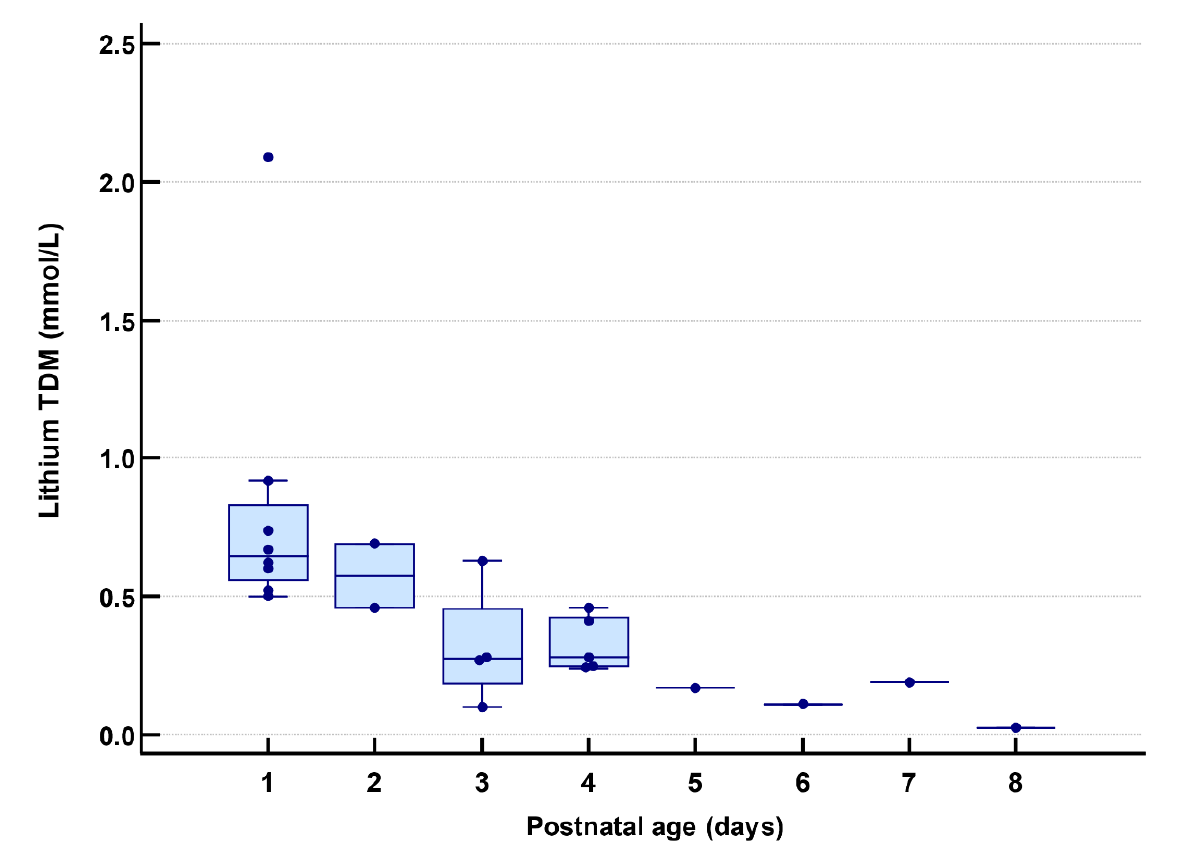
Figure 4. Available lithium therapeutic drug monitoring (TDM) data (mmol/L) of the included neonates are presented as daily boxplots covering postnatal age day 1 to day 8. One value reported as below the limit of quantification (LOQ), <0.05 mmol/L, was replaced by LOQ/2 = 0.025. Table 5. Neurological assessment and lithium neonate/mother therapeutic drug monitoring (TDM) ratio.